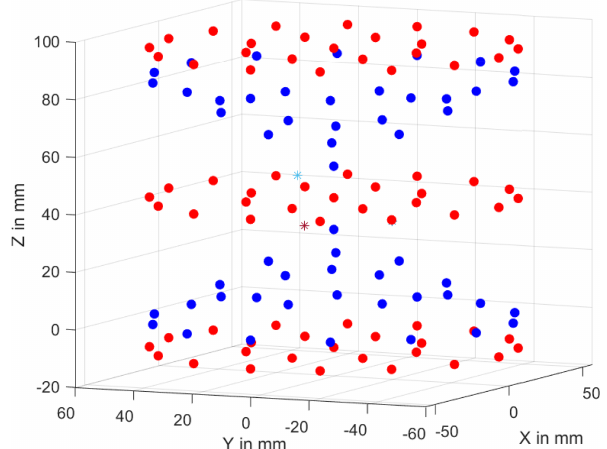
Figure 3. Simulation artefact (nominal positions of the sphere cen- tres) consisting of three layers of 25 spheres in red (inspired by Mu- ralikrishnan et al., 2019a, b, c and Jaganmohan et al., 2020) and two multi-sphere standards with 27 spheres (in blue). There are further symmetry-breaking spheres indicated by